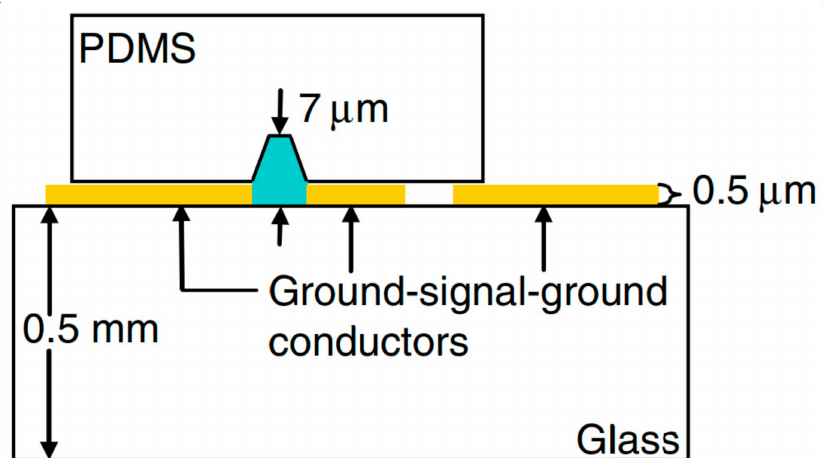
Figure 2. The scheme of the proposed Coplanar Waveguide (CPW) module for heating the liquids